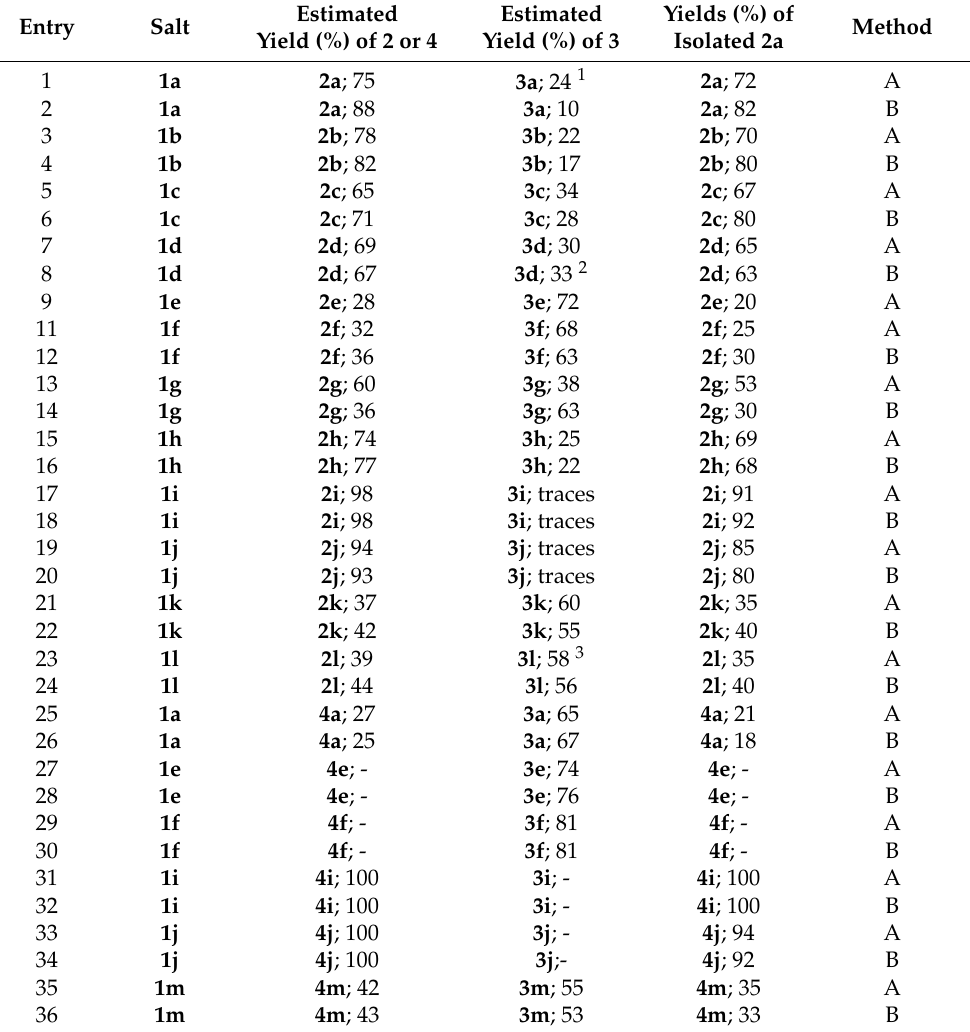
Table 3. GC-MS analyses of crude residues of bromodediazotation and chlorodediazotation. Estimated Entry Salt Yield (%) of 2 or 4